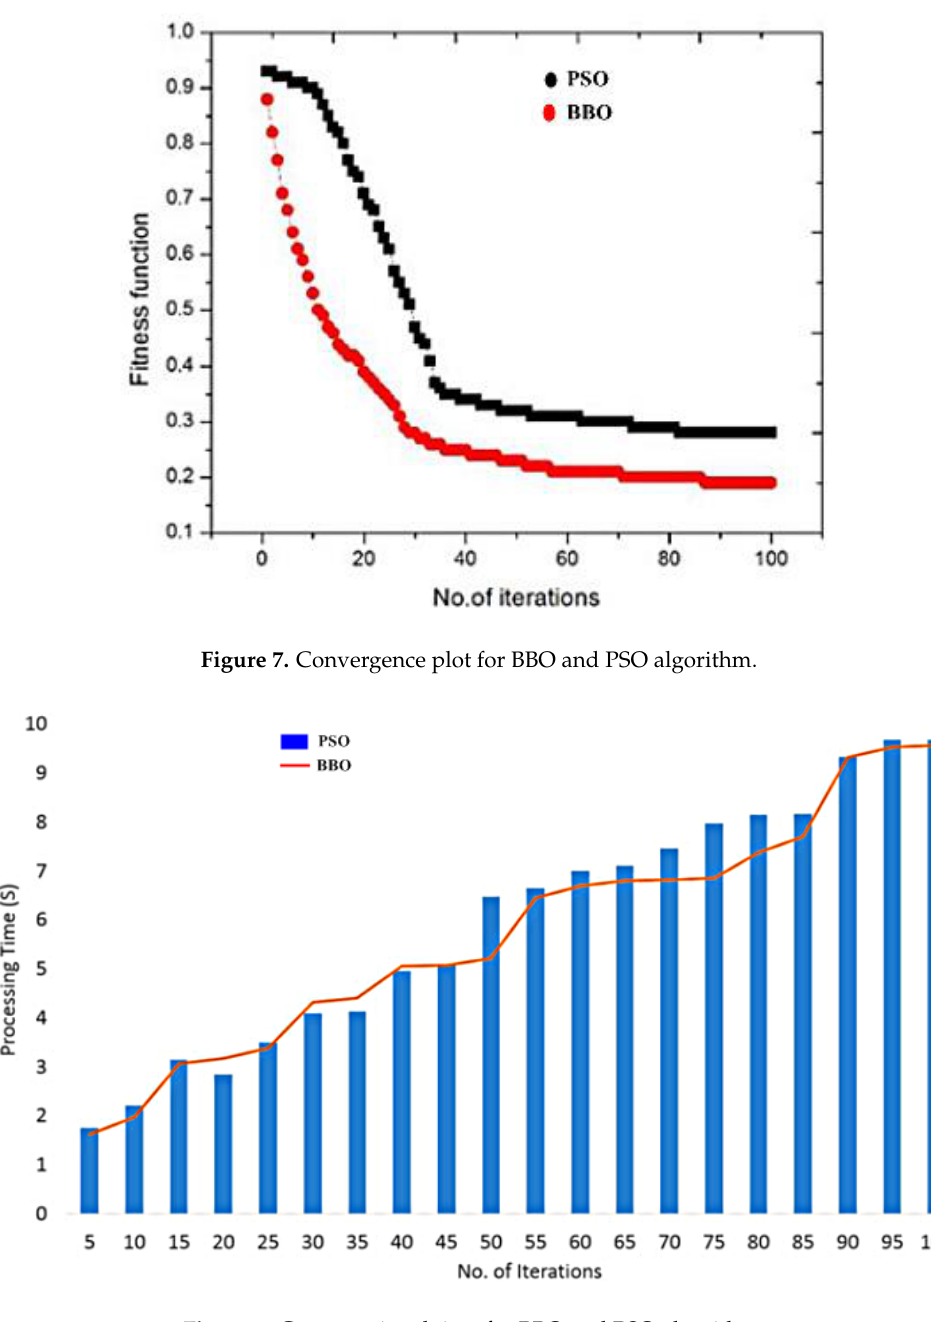
Figure 8. Computational time for BBO and PSO algorithms.